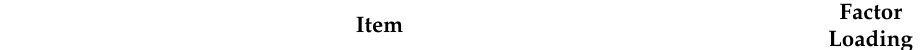
Table 1. Confirmatory factor analysis.